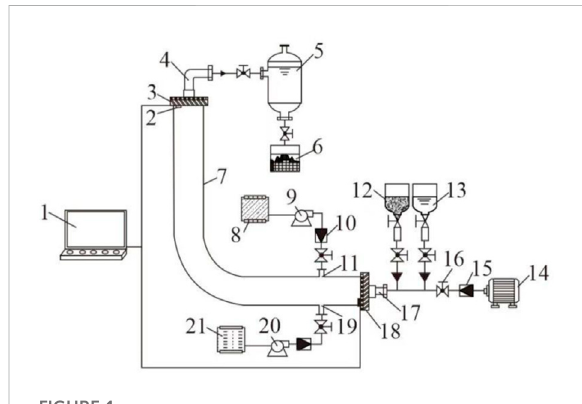
FIGURE 1 Device diagram of oil-gas-water multiphase fl ow